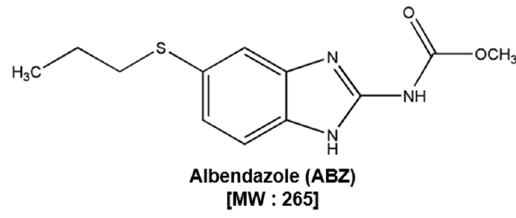
Figure 1. The structure of albendazole (ABZ).